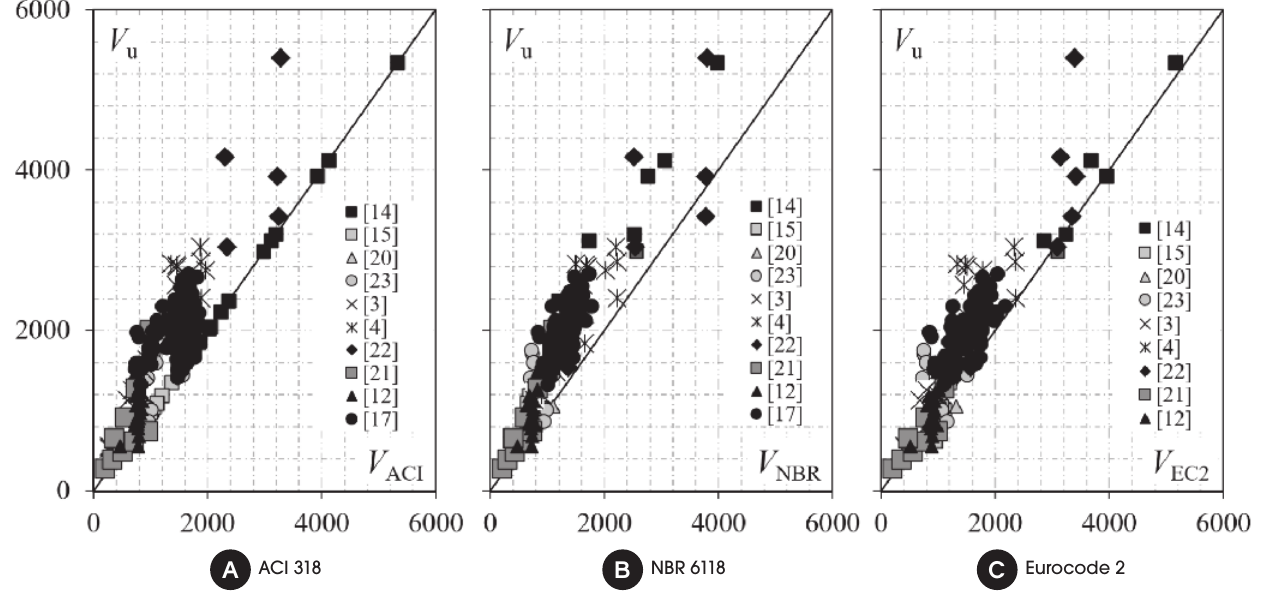
Figure 12 Comparison between experimental and theoretical results